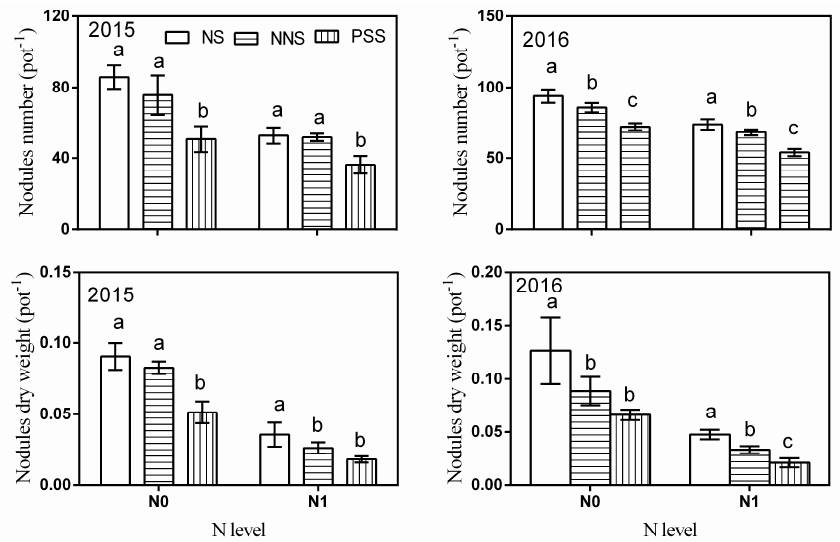
Figure A3. Effects of nitrogen levels and root separation patterns on nodule number and dry weight of alfalfa. Different lowercase letters show significant difference between root separation patterns under the same nitrogen levels at p ≤ 0.05. Table A3. Results of repeated measures ANOVA about effects of year (Y), nitrogen levels (N), and root separation method (RS) on %Ndfa and Ndfa of alfalfa.